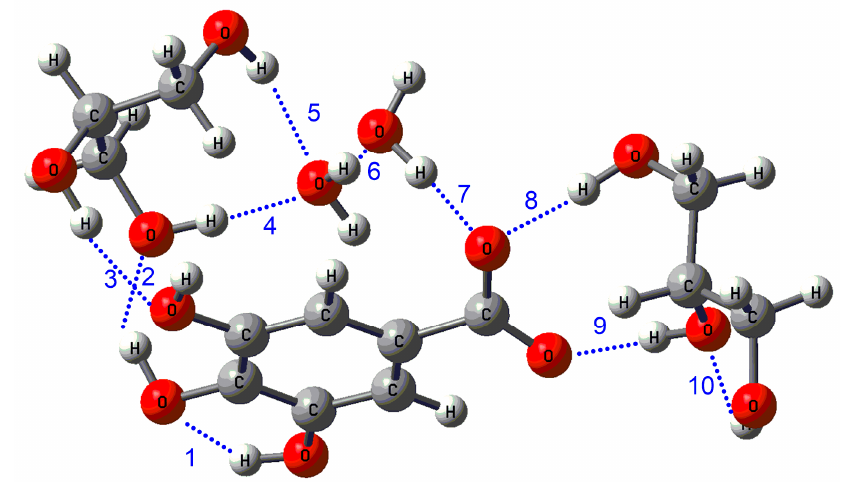
Figure 3. Optimized structures at DFT M06-2X / 6-311 + G(d,p) level for deprotonated gallic acid with glycerol and water. Table 3. Calculated distances, and stabilization energies at DFT M06-2X / 6-311 + G(d,p) level for the hydrogen bonds between deprotonated gallic acid, glycerol and water.